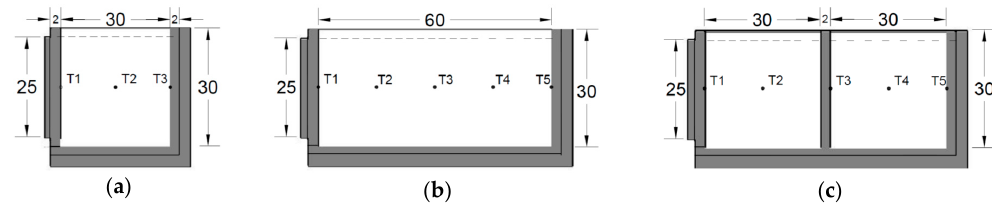
Figure 2. Thermocouple positions and dimensions of heat sinks, ( a ) A; ( b ) B and ( c ) C.